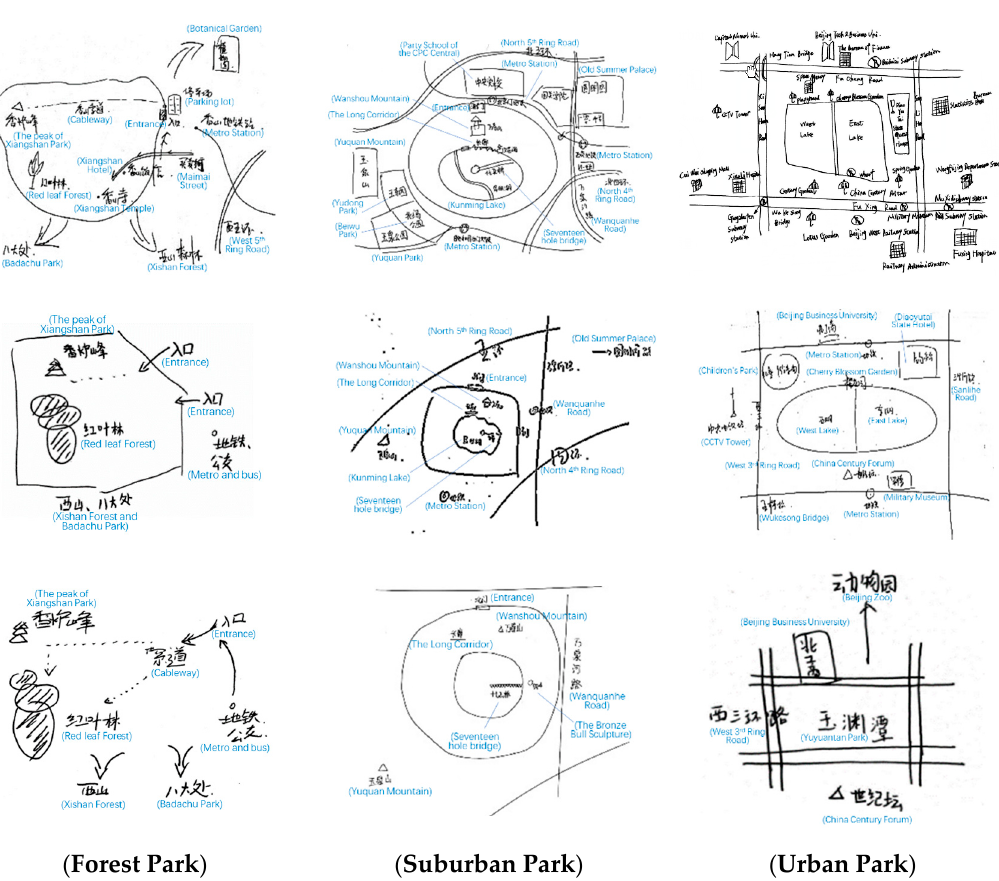
Figure 3. The example of hand-drawn cognitive maps of this study.